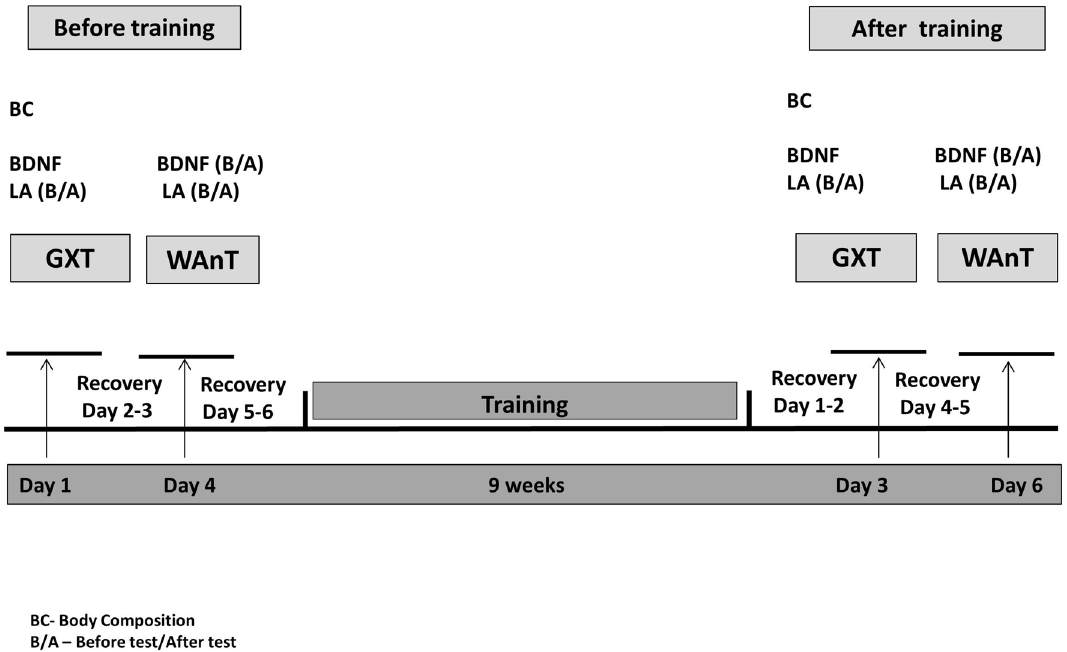
Figure 5. Scheme of GXT and WAnT tests before and after 9-week